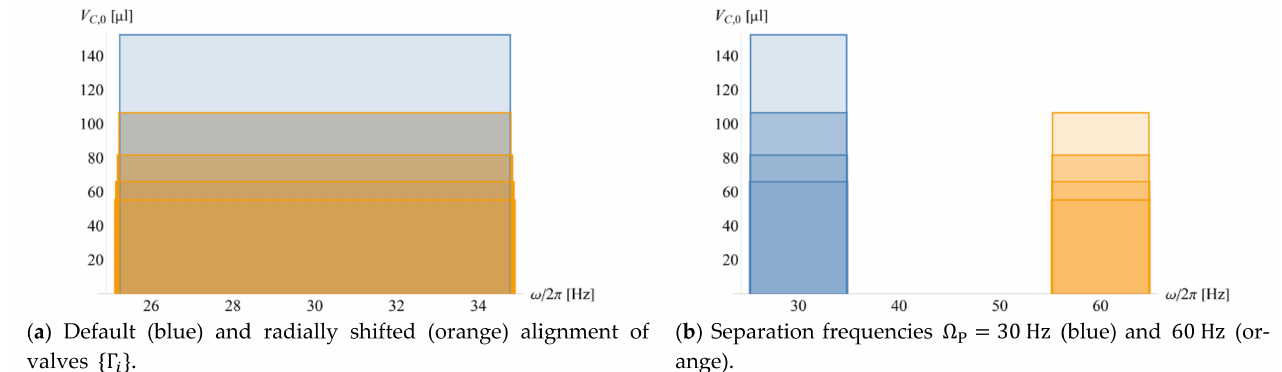
Figure 9. Event-triggered flow control in exemplary bioassay protocol. ( a ) The set of valves { Γ i } at their default (blue) positions { R i } , and radially shifted outwards by 0.5 cm (orange), which is a common requirement towards microfluidic LSI. All frequency bands { Ω i ± M · ∆Ω i } are centered at identical rates Ω i = Ω . ( b ) The same radial distribution { R i } is operated at different spin rates Ω i = Ω P , showing that event triggering is advantageous for enabling high spin rates ω , e.g., for improving and accelerating plasma